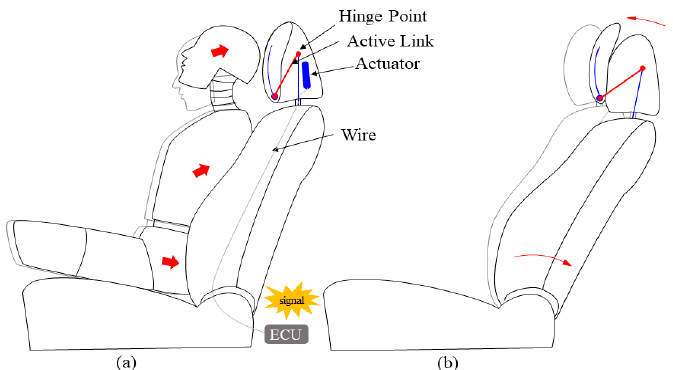
Figure 3. Schematic diagram of proactive headrest: ( a ) components of the proactive headrest; ( b ) conceptual diagram of proactive headrest operation.